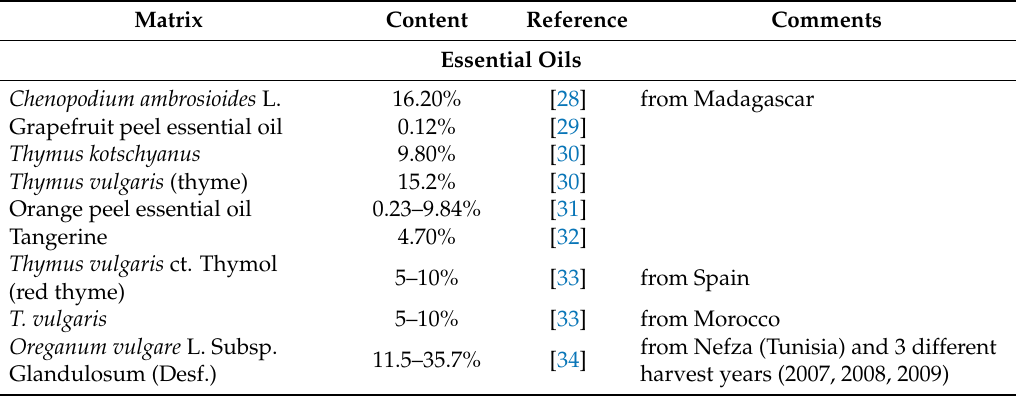
Table 2. p-Cymene levels in some essential